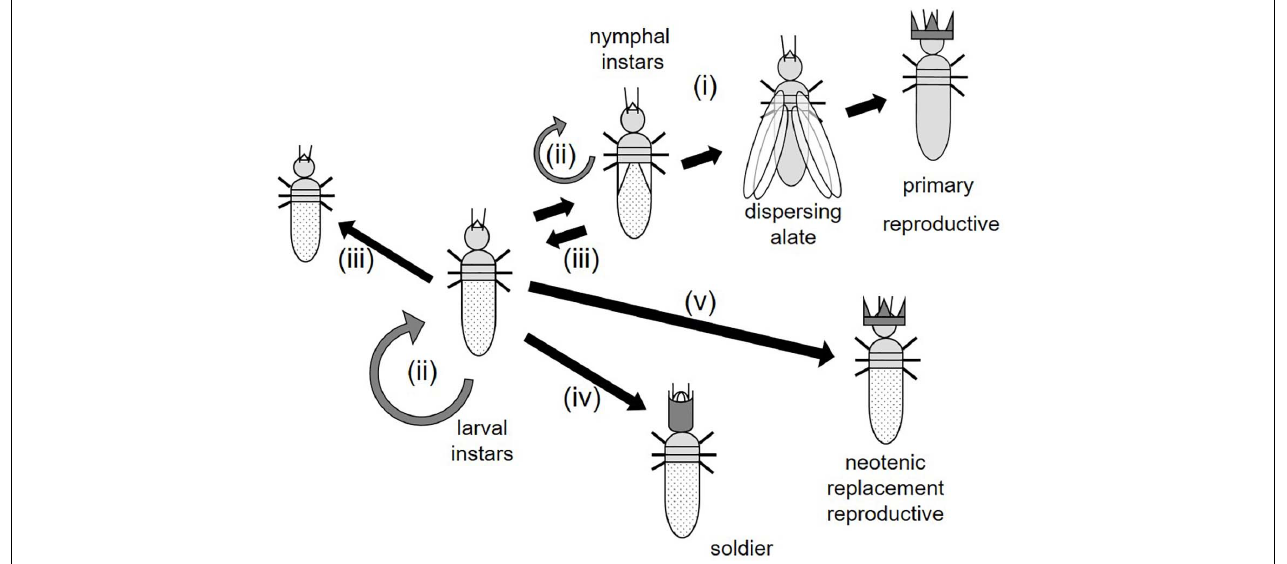
FIGURE 1 | Developmental plasticity of wood-dwelling termites. Immatures (larval and nymphal instars) can (i) develop progressively via several nymphal instars into winged sexuals (alates) that disperse and found a nest as primary reproductives, (ii) remain in the same instar by doing stationary molts (gray circles), (iii) develop regressively into an “earlier” instar, (iv) develop into a soldier, or (v) a neotenic replacement reproductive. For further information, see text. Adapted from Korb et al. (2012).